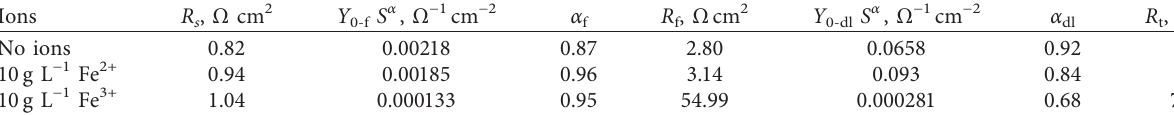
° C containing different ions. 2 SO 4 solutions at 75